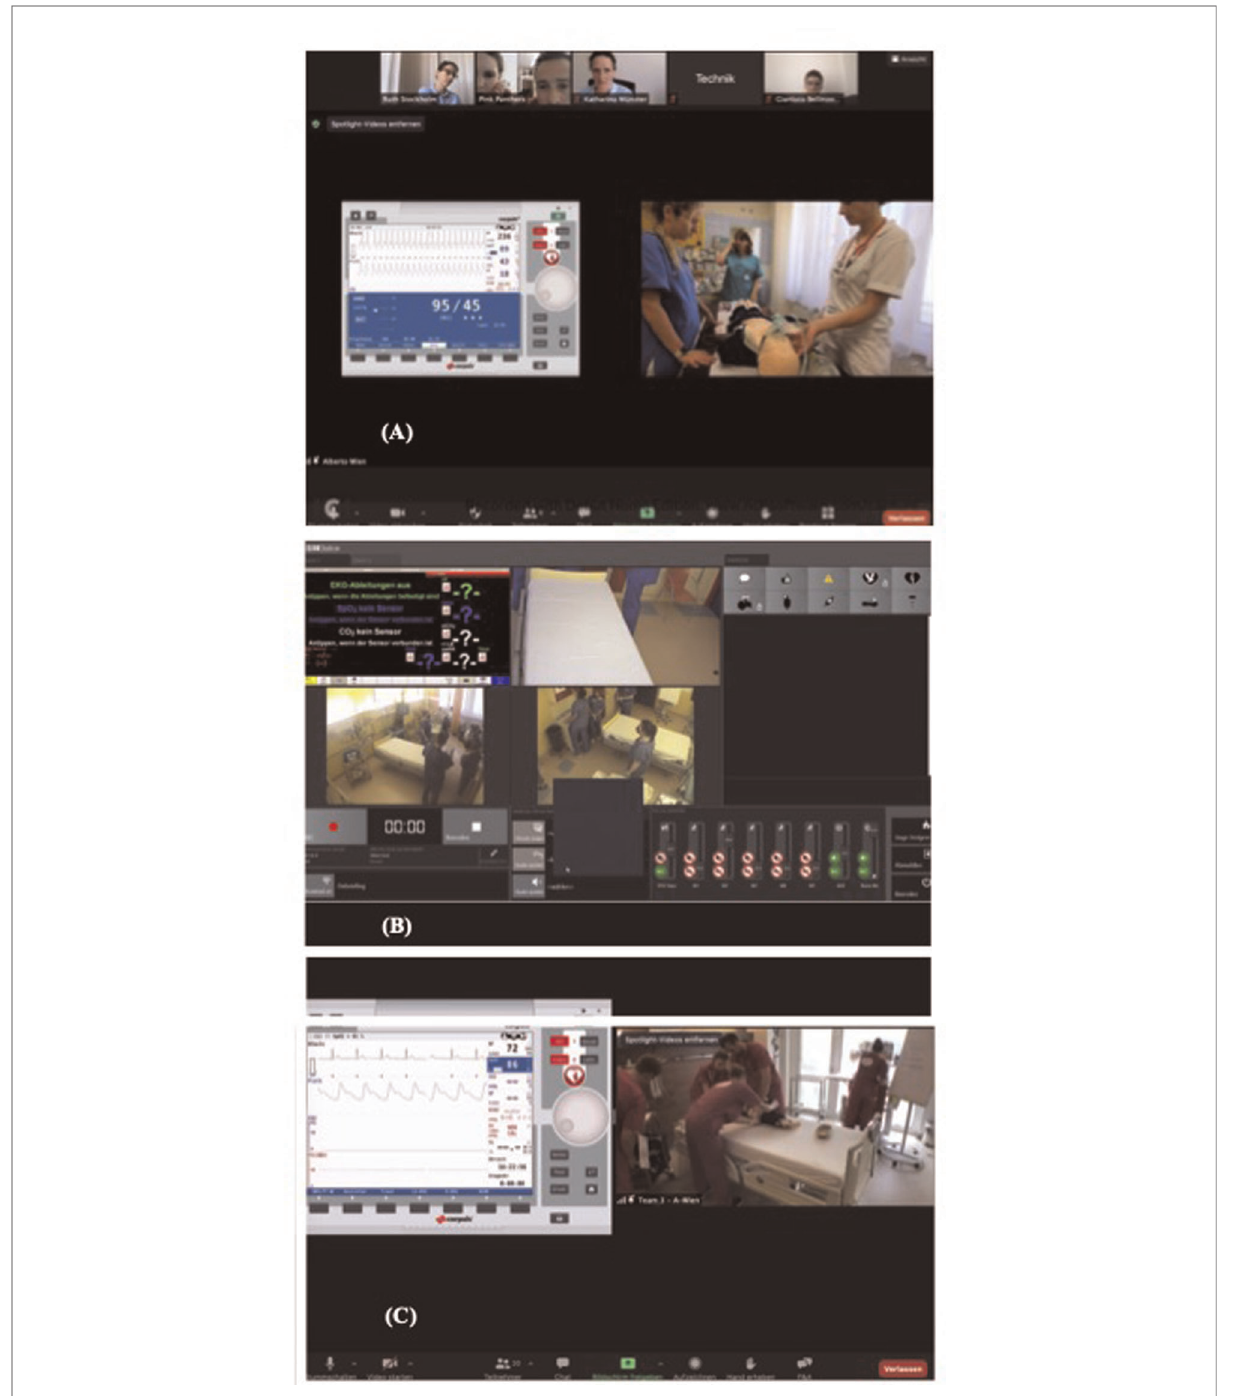
FIGURE 2 Participant and facilitator zoom®screen views. ( A ) Avatar simulation. Side-by-side format showing the operator ’ s (technician ’ s) shared screen of patient monitor vitals from a distance (located in Vienna), the avatars ’ video of the simulated scenario and the gallery of participants, facilitators [jury members located in Stockholm (RML), Münster, Germany, and Bellinzona, Switzerland] and operator (technician), located in Vienna, Austria. Operator is in the same room and behind the camera. ( B ) Distance simulation using ©SIMStation. Side-by-side format showing the ©SIMStation ’ s three camera views and local confederate operator ’ s shared screen of patient monitor vitals transmitted via connection to Zoom®. ( C ) Distance simulation using iSimulate. Side-by-side format showing the operator ’ s (technician ’ s) shared screen of patient monitor vitals from a distance (Vienna) and the participants ’ video of the simulated scenario transmitted by a camera connected to